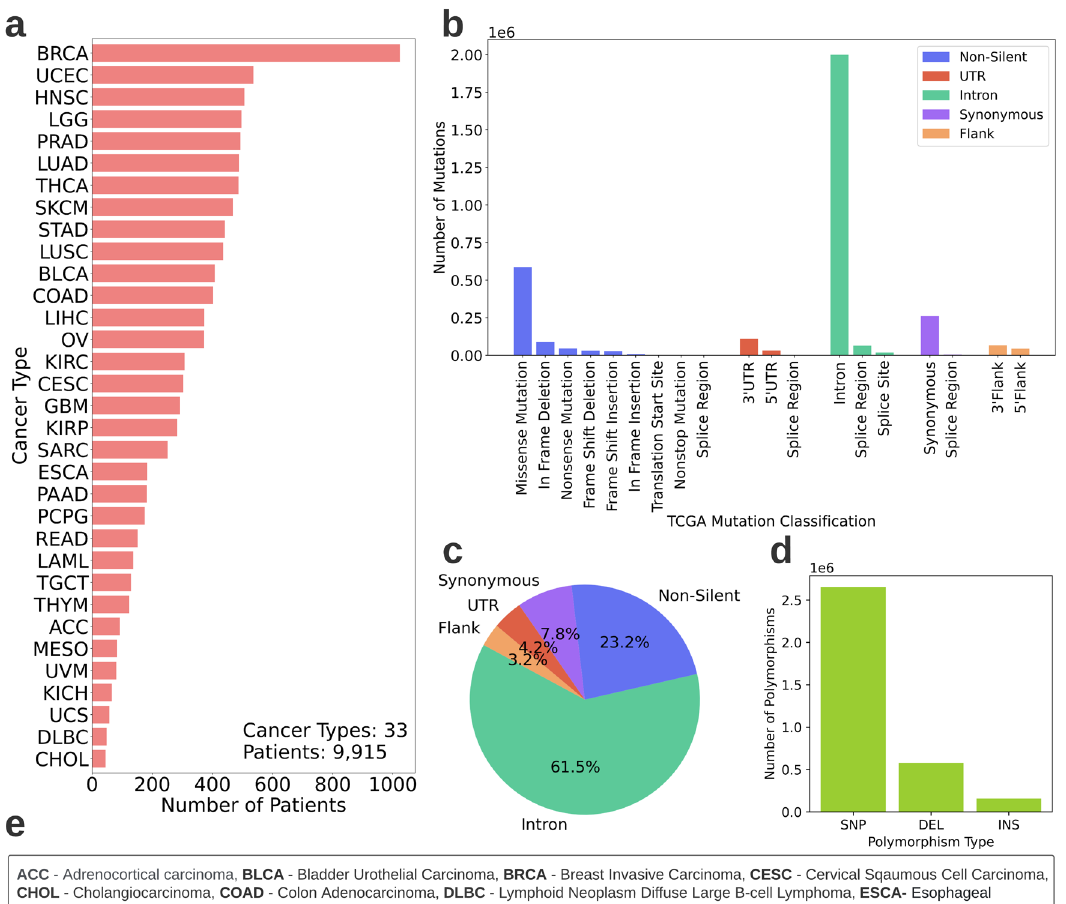
Fig. 1 TCGA data characteristics. Description of the data retrieved from TCGA after initial preprocessing (discarding patients with missing genomic or clinical data and patients with multiple genomic samples). Overall, 9915 patients across 33 cancer types are included in the study. a Patient distribution across cancer types. b Sorting TCGA mutations to fi ve categories for the study. The x -axis depicts the mutation classi fi cation according to TCGA*. The y -axis depicts the number of mutations in the TCGA mutation categories. The legend depicts the fi ve categories to which the mutations are sorted for this study. *Note: In TCGA, Synonymous mutations are referred to as “ Silent ” . As the terms are in fact not interchangeable (synonymous mutations are a subcategory of silent mutations) we replace the term “ Silent ” with “ Synonymous ” where needed. c Mutation type distribution. The distribution includes all mutations of the 9915 patients. d Polymorphism type distribution. Mutations could be either Single Nucleotide Polymorphisms (SNP), Deletions (DEL) or Insertions (INS). The distribution includes all mutations of the 9915 patients, e Names and abbreviations of the 33 cancer